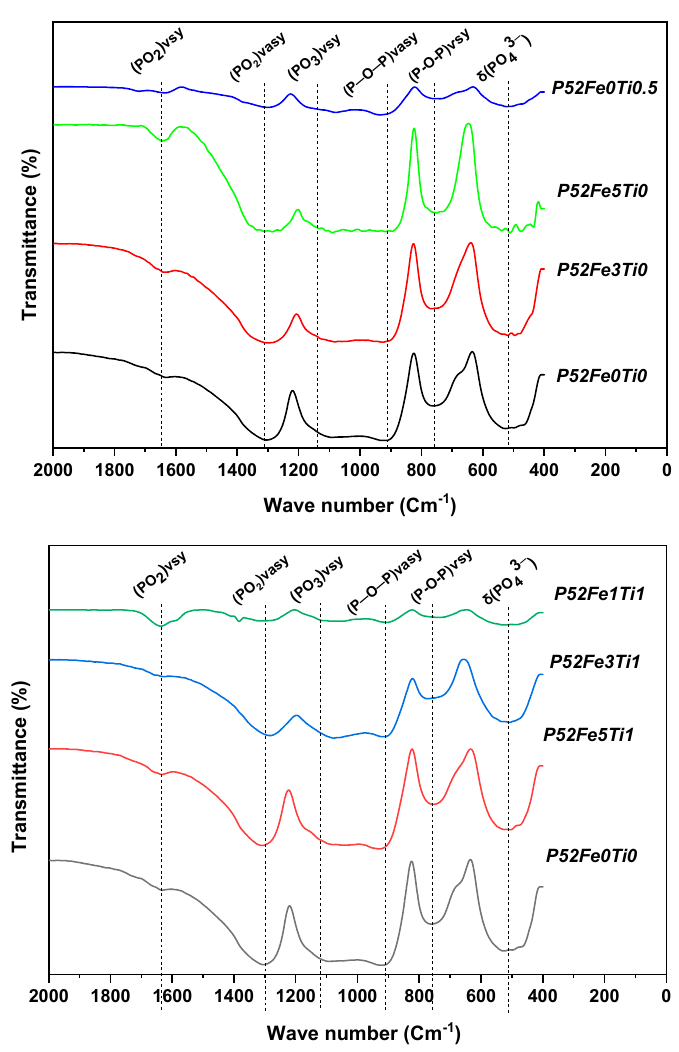
Figure 2. IR spectra of phosphate glasses with different compositions.